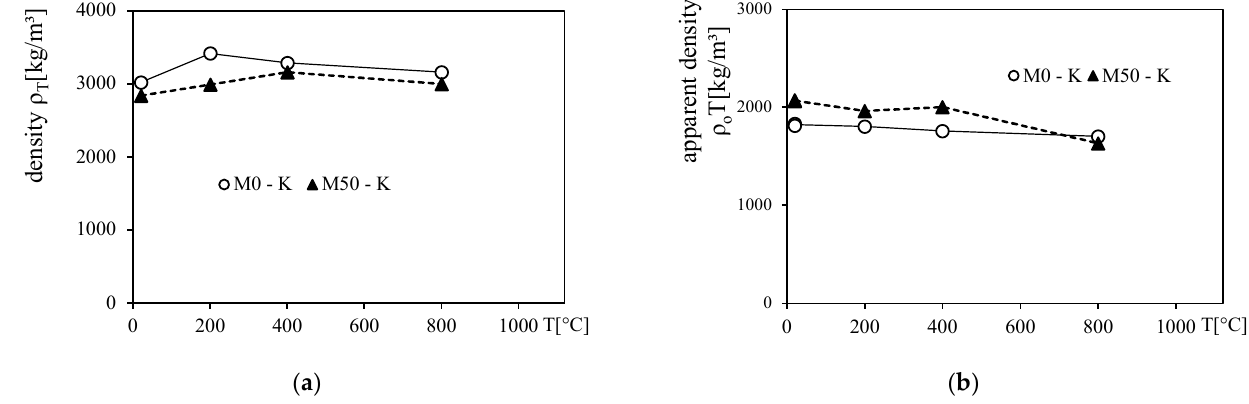
Figure 4 . ( a ) Specific density ρ T and ( b ) apparent density ρ oT in kg/m 3 of heated samples.